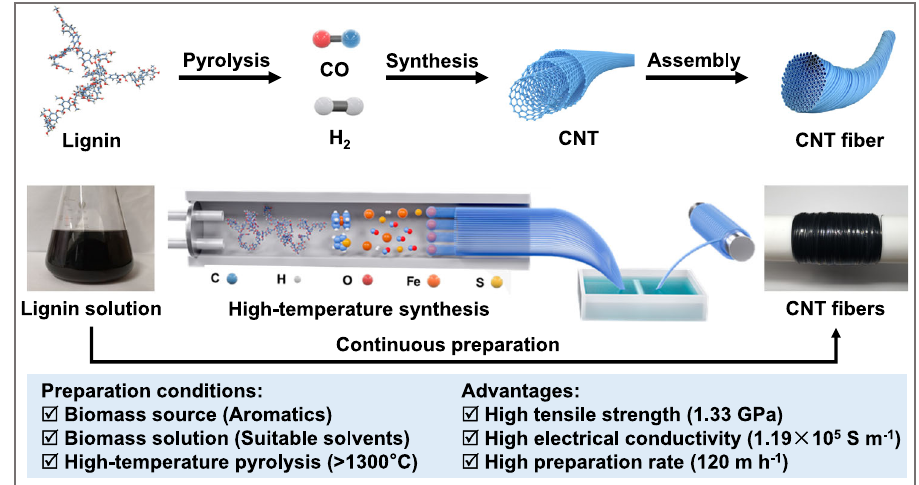
Fig. 1 | Continuous production of CNT fi bers. Synthesis mechanism from lignin to CNT fi bers and its respective processing